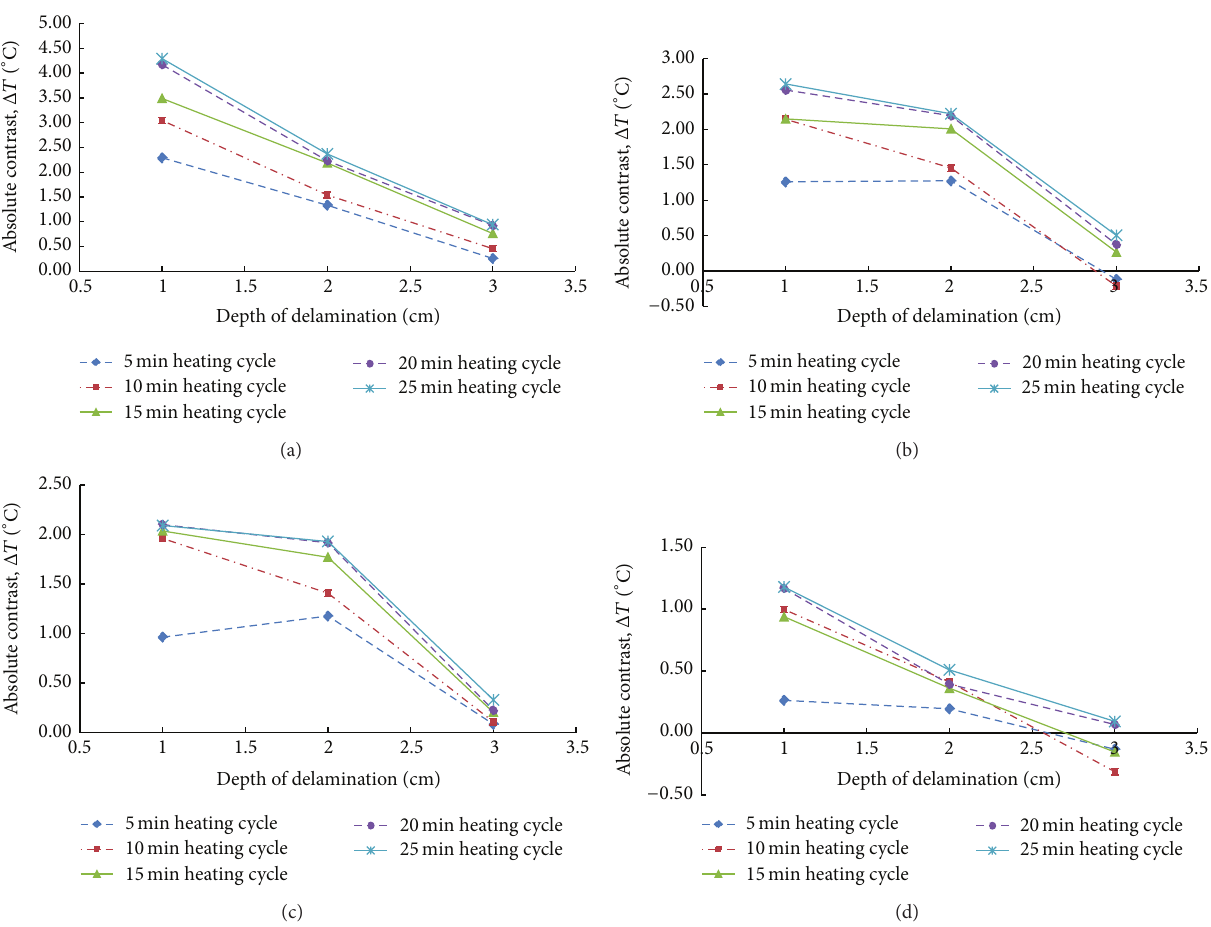
relationship between the observation time and the depth of the defect can be expressed as